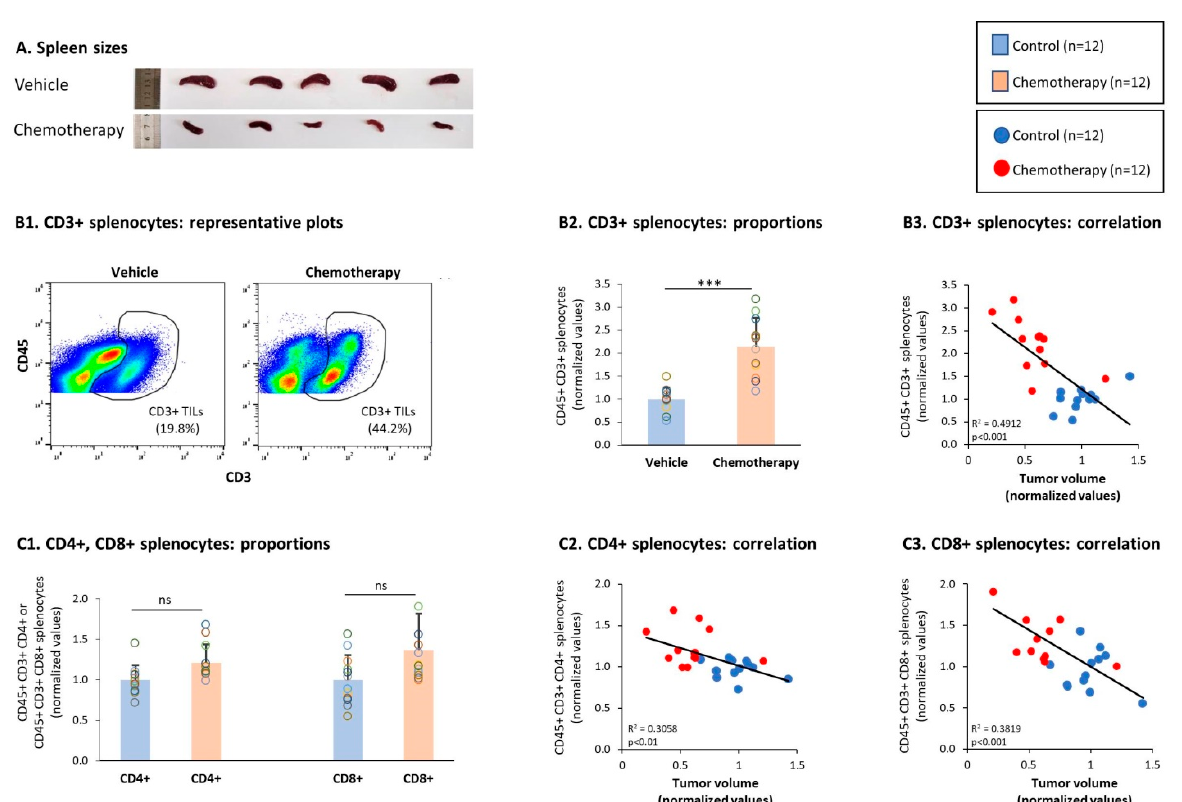
Figure 7. Chemotherapy elevated the proportions of CD3+ splenocytes but did not have a significant impact on the proportions of CD4+ and CD8+ splenocytes. Murine 4T1 TNBC cells were syngrafted to BALB/c mice in the presence of chemotherapy or a vehicle control; procedures and analyses were performed as described in Figure 3. ( A ) Spleen sizes. Spleens excised at the end of the third experiment are demonstrated: in the two groups, there were n = 5 mice in each group. ( B ) CD3+ splenocytes, gated out of CD45+ cells. ( B1 ) Representative flow cytometry analyses of CD3+ splenocytes. ( B2 ) Proportions of CD3+ splenocytes. ( B3 ) CD3+ splenocytes correlated with tumor volumes. ( C ) CD4+ splenocytes and CD8+ splenocytes, gated out of CD45+ CD3+ cells. ( C1 ) Proportions of CD4+ and CD8+ splenocytes. ( C2 , C3 ) CD4+ splenocytes and CD8+ splenocytes, respectively, correlated with tumor volumes. In the proportion and correlation analyses, the average value of the vehicle-treated group in each biological repeat was given the value of 1 and the values of all mice analyzed in that repeat were normalized accordingly. The value of each mouse is presented as a dot. *** p < 0.001, ns: not significant (two-tailed unpaired Student’s t -test; correlation analyses: Pearson; T.DIST).